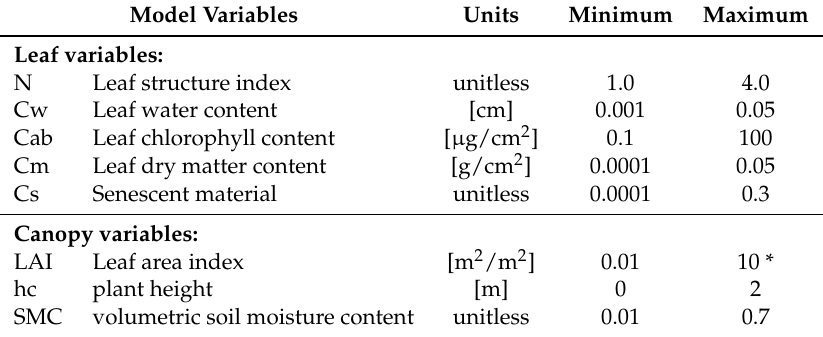
Table 1. Range of vegetation input variables used to establish the SCOPE 500 LUT according to Latin Hypercube sampling. The other SCOPE variables are kept fixed to the SCOPE default values as provided in Appendix A (Table A1). * A LAI of 10 may be too extreme, a LAI until 6 would be more